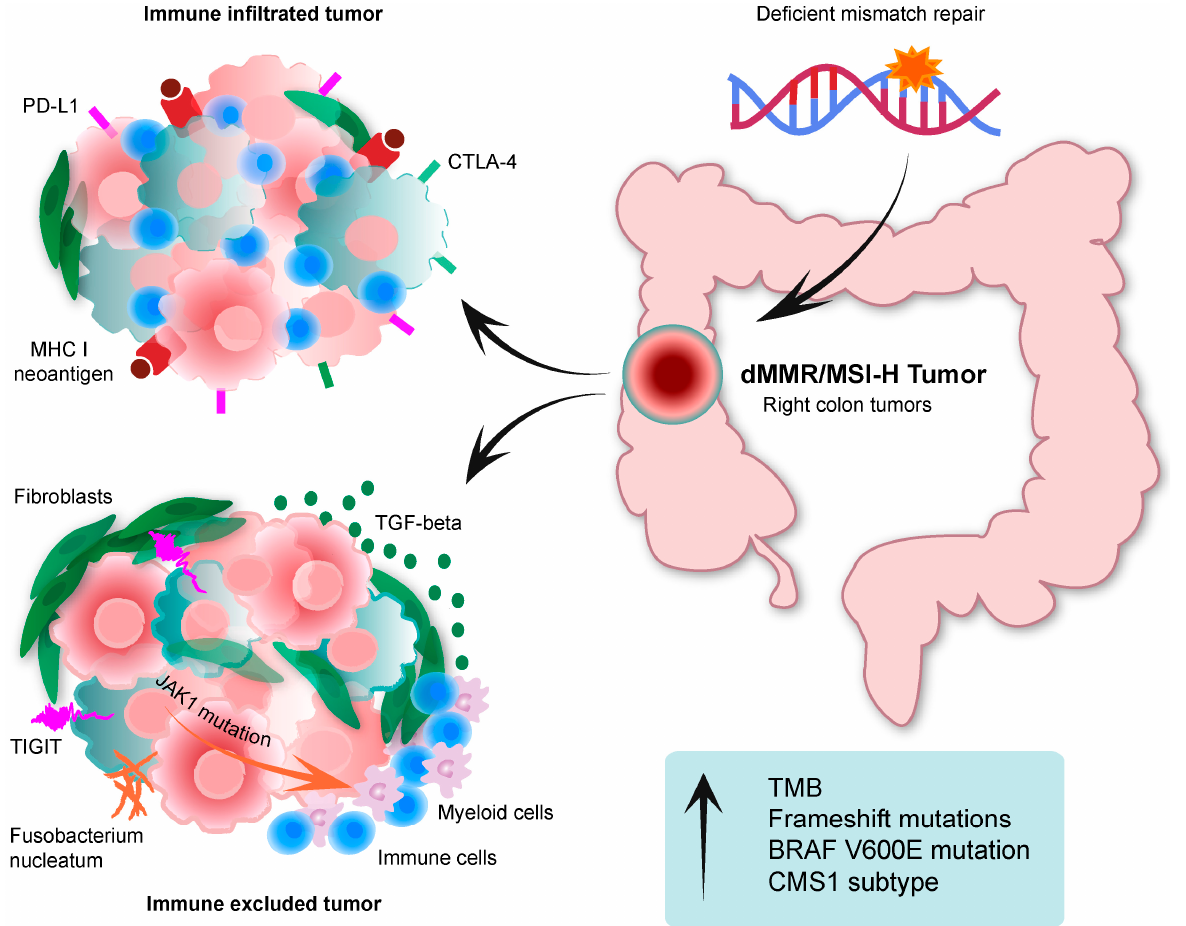
Figure 1. Molecular features of immune infiltrated or immune excluded dMMR/MSI-H CRC. Immune infiltrated tumors are characterized by increased PD-L1 and CTLA-4 expression as well as elevated neoantigen presentation. Immune excluded tumors feature a TGF-beta enriched tumor microenvironment with abundant immunosuppressive myeloid cells and fibroblasts. Arrow in blue box means increased. dMMR: deficient mismatch repair. MSI-H: high microsatellite instability.